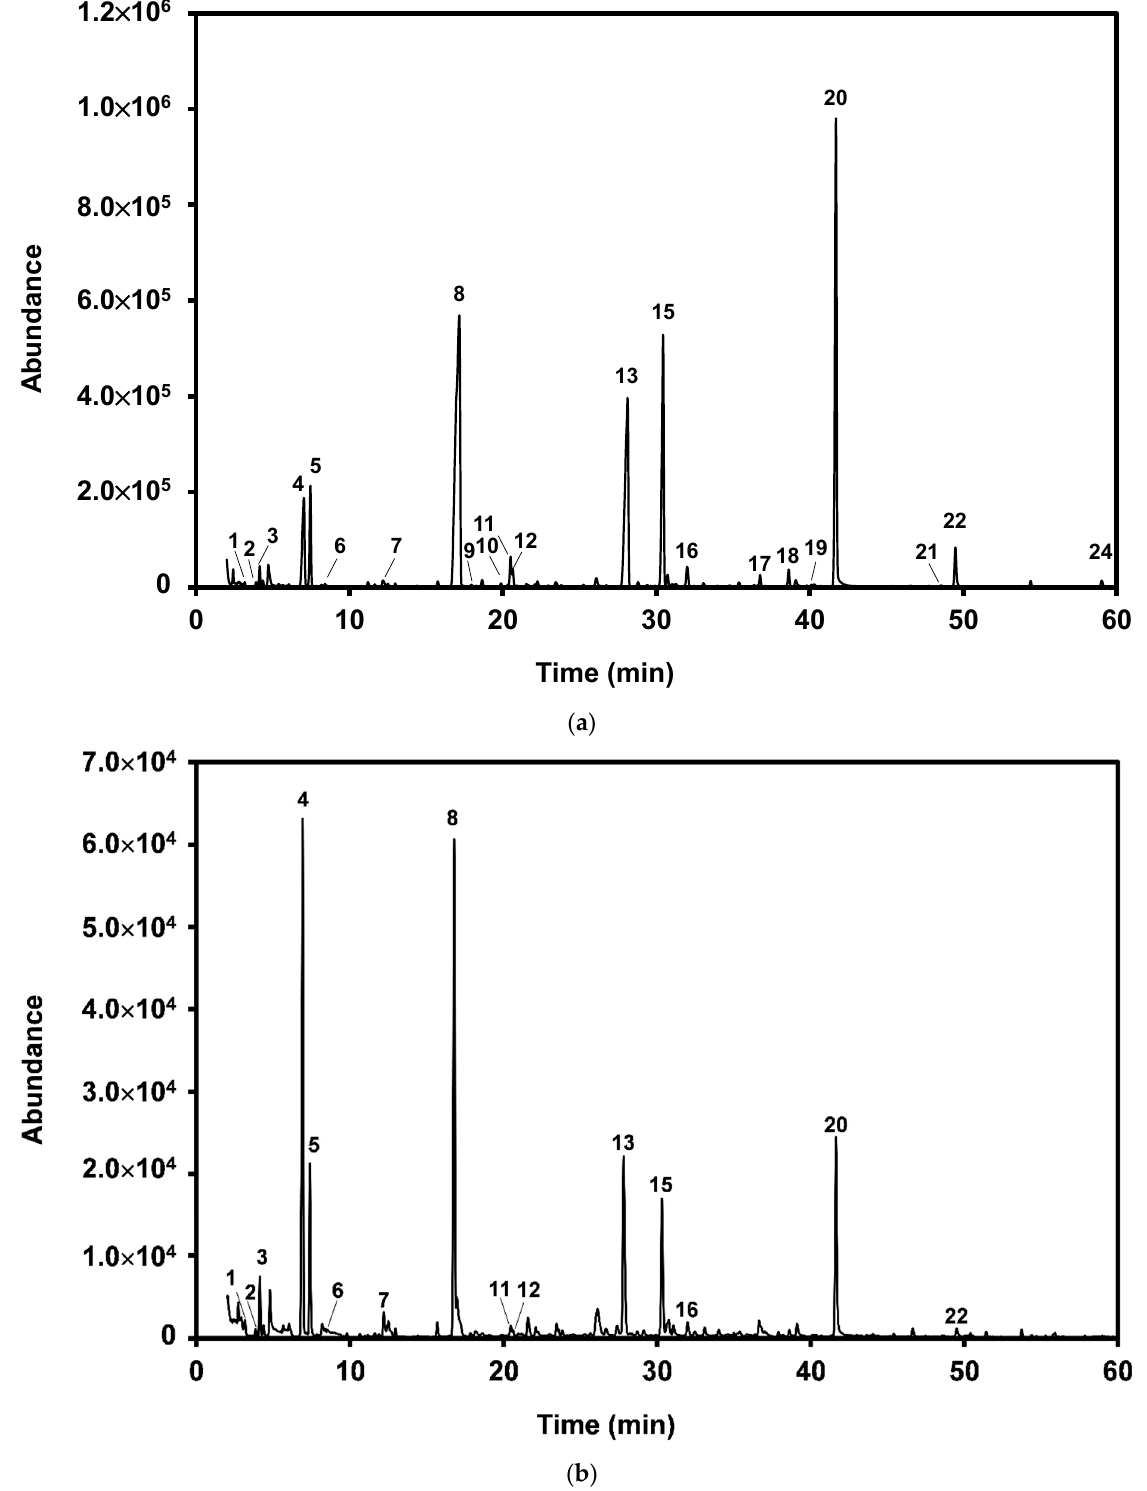
Figure 2. Typical chromatograms of red wines without ADSI cork powder addition using SPME headspace sampling with re-equilibration ( a ) and without re-equilibration ( b ). Only the major peaks are highlighted. For peak identification, refer to Table 6.